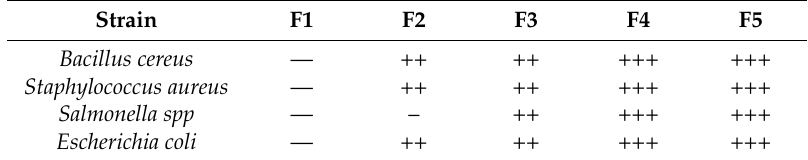
Table 3. Inhibition of CS/PVA/GO films against bacterial strains.